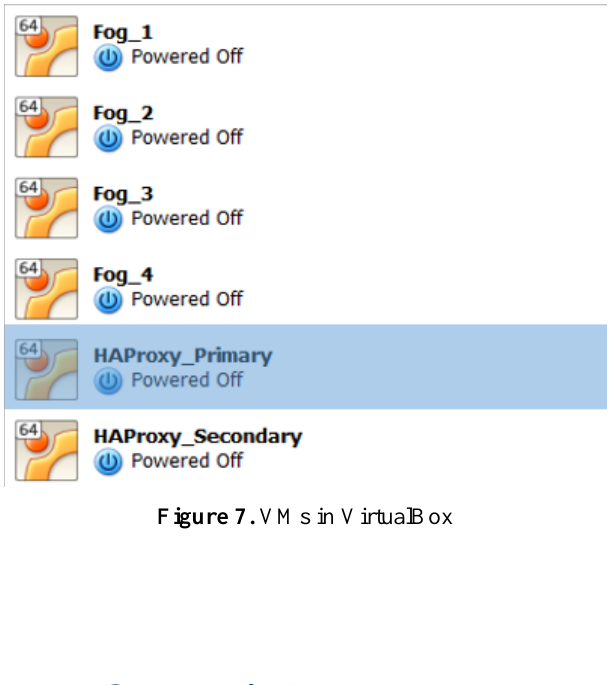
Figure 7. All VMs are configured to operate Apache2, PHP5, MySQL, PHP-Mosquitto, DM technique, and network configuration.